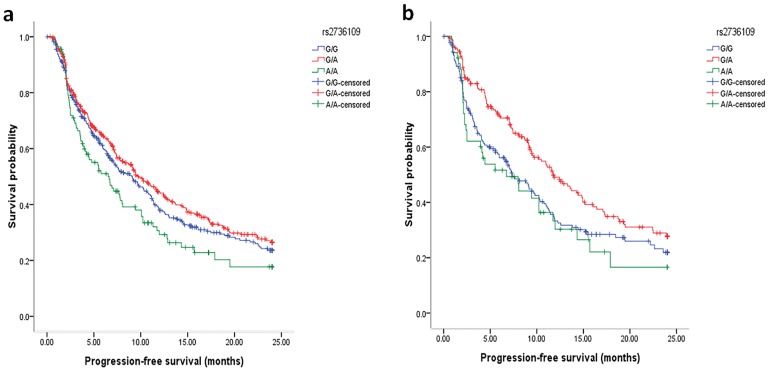
Kaplan-Meier curve of progression-free survival according to TERT rs2736109 polymorphism in (a) overall 1004 patients and (b) age > 58 supgroup.These plots were generated by the SPSS software.